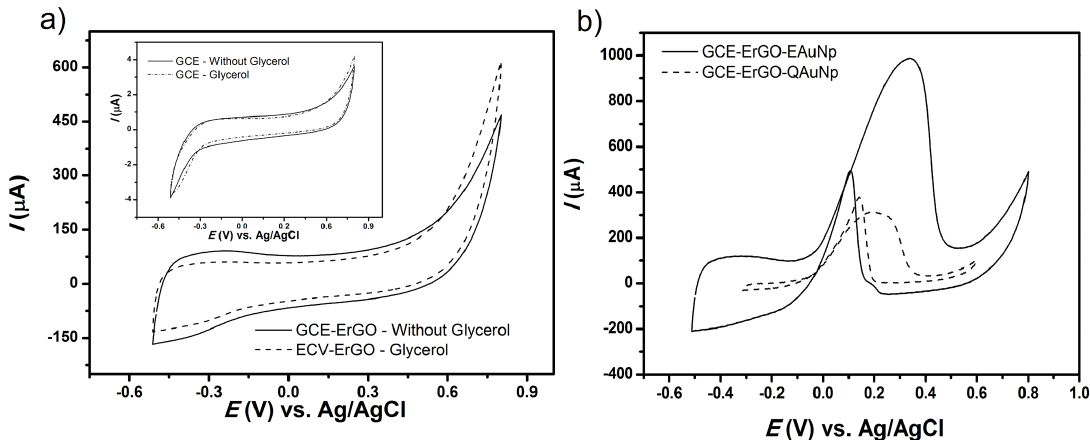
Figure 3. Cyclic voltammograms of GCE-ErGO without glycerol and with glycerol, the introduced graphic is the same analysis but using the CGE (a) and Cyclic voltammograms of GCE-ErGO modified with QAuNp and EAuNp (b), in 0.2 mol L -1 KOH solution containing 3 mmol L -1 glycerol using 30 mV s -1 scan rate.